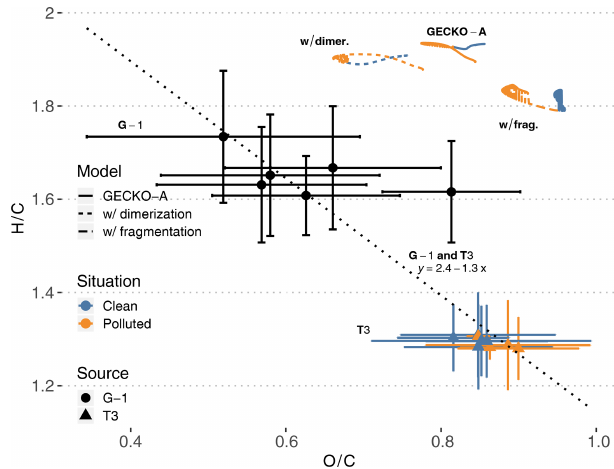
Figure 10. T3 site (colored triangles), airborne (black dots) and modeled (lines, afternoon of second day) van Krevelen diagrams of H / C ( y axis) versus O / C ( x axis) average ratios in SOA. The vertical and horizontal range of the experimental data denotes the standard deviation of measured concentrations. Cases are identified as clean (blue) and polluted (orange). Airborne data were filtered to only include measurements taken within 20km of the T3 site. The dotted line and the associated equation depict the linear regres- sion obtained with all experimental points (T3 and G-1). Modeled lines depict three different calculations (see Sect. 4.2.4): the ref- erence calculation (continuous lines, labeled GECKO-A), a calcu- lation where all C 10 are supposed to be dimerized (short dashes, labeled w/ dimer.) and a calculation where all C 10 are supposed to fragment (long dashes, labeled w/